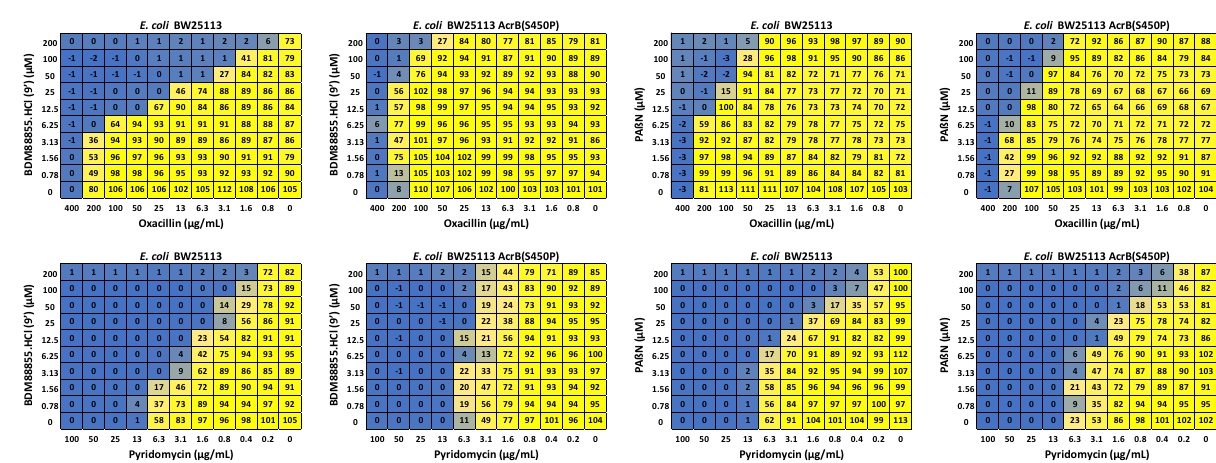
Fig. 1 Checkerboard assay evaluating pyridomycin and oxacillin antibiotic activity in the presence of different concentrations of BDM88855.HCl (9 ’ ) and PA β N. Experiments were performed on both E. coli BW25113 and the pyridylpiperazine resistant E. coli isolate (carrying the S450P AcrB mutation) to con fi rm the on-target activity of BDM88855.HCl ( 9 ’ ). Bacterial viability was determined using the resazurin reduction assay and is expressed as a percentage resazurin reduction compared to the untreated bacteria, with this viability colour coded from yellow (100%) to blue (0%). Data represent the mean bacterial viability of at least four independent replicates. Source data are provided as a Source Data fi le. NATURE COMMUNICATIONS| (2022) 13:115